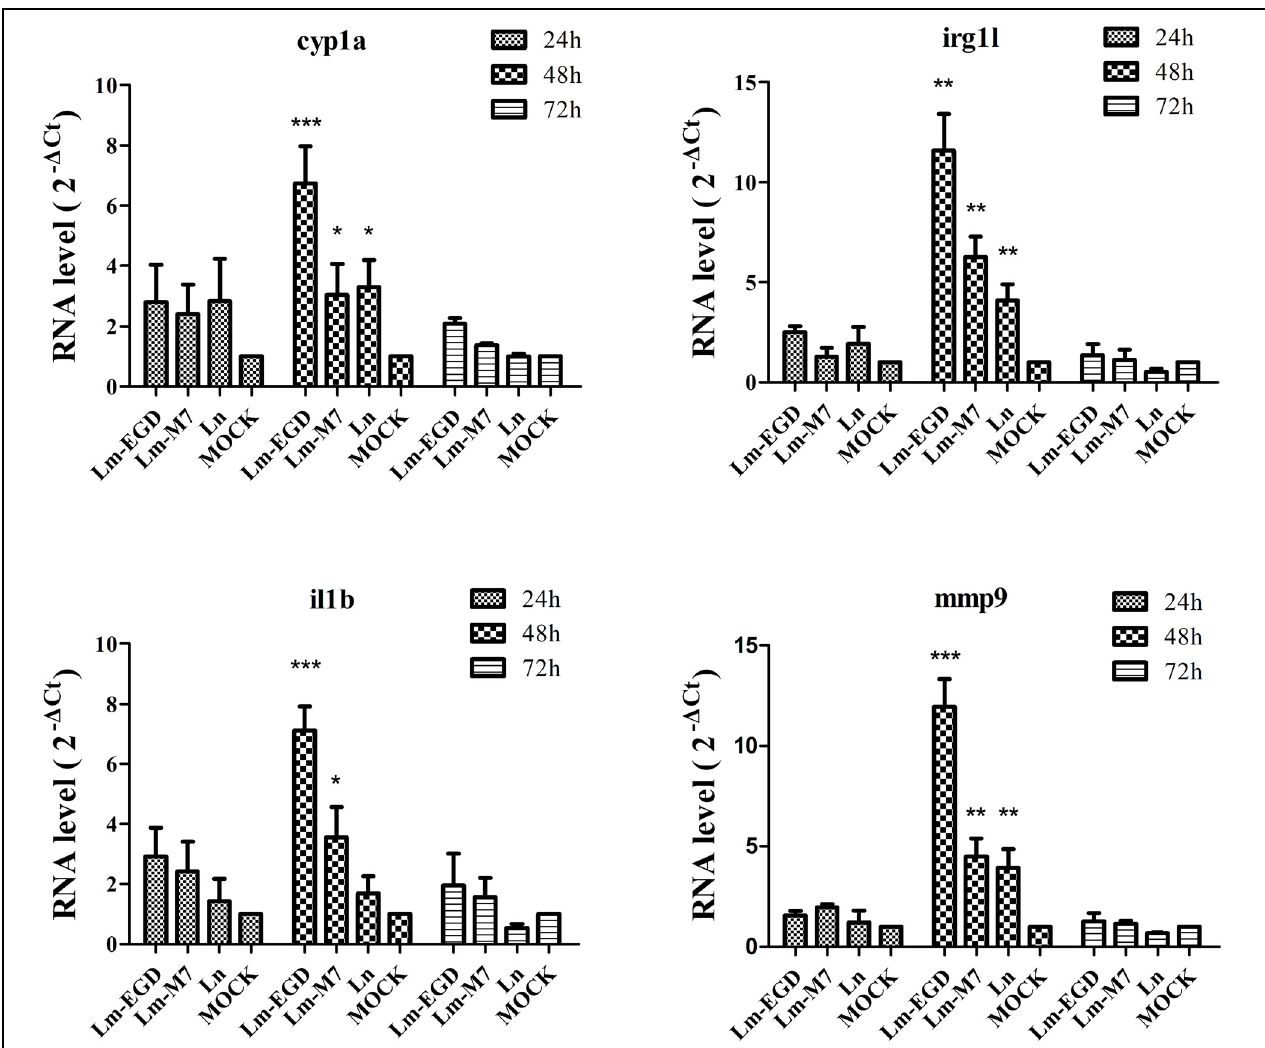
FIGURE 2 | Transcriptional analysis by qPCR of innate immune related genes cyp1a , irg1l , il1b, and mmp9 of germ-free zebrafish infected at 5 dpf by 24 h of immersion with different listerial strains. Data are expressed as mean ± SD of four independent experiments (each with 10 embryos pooled for